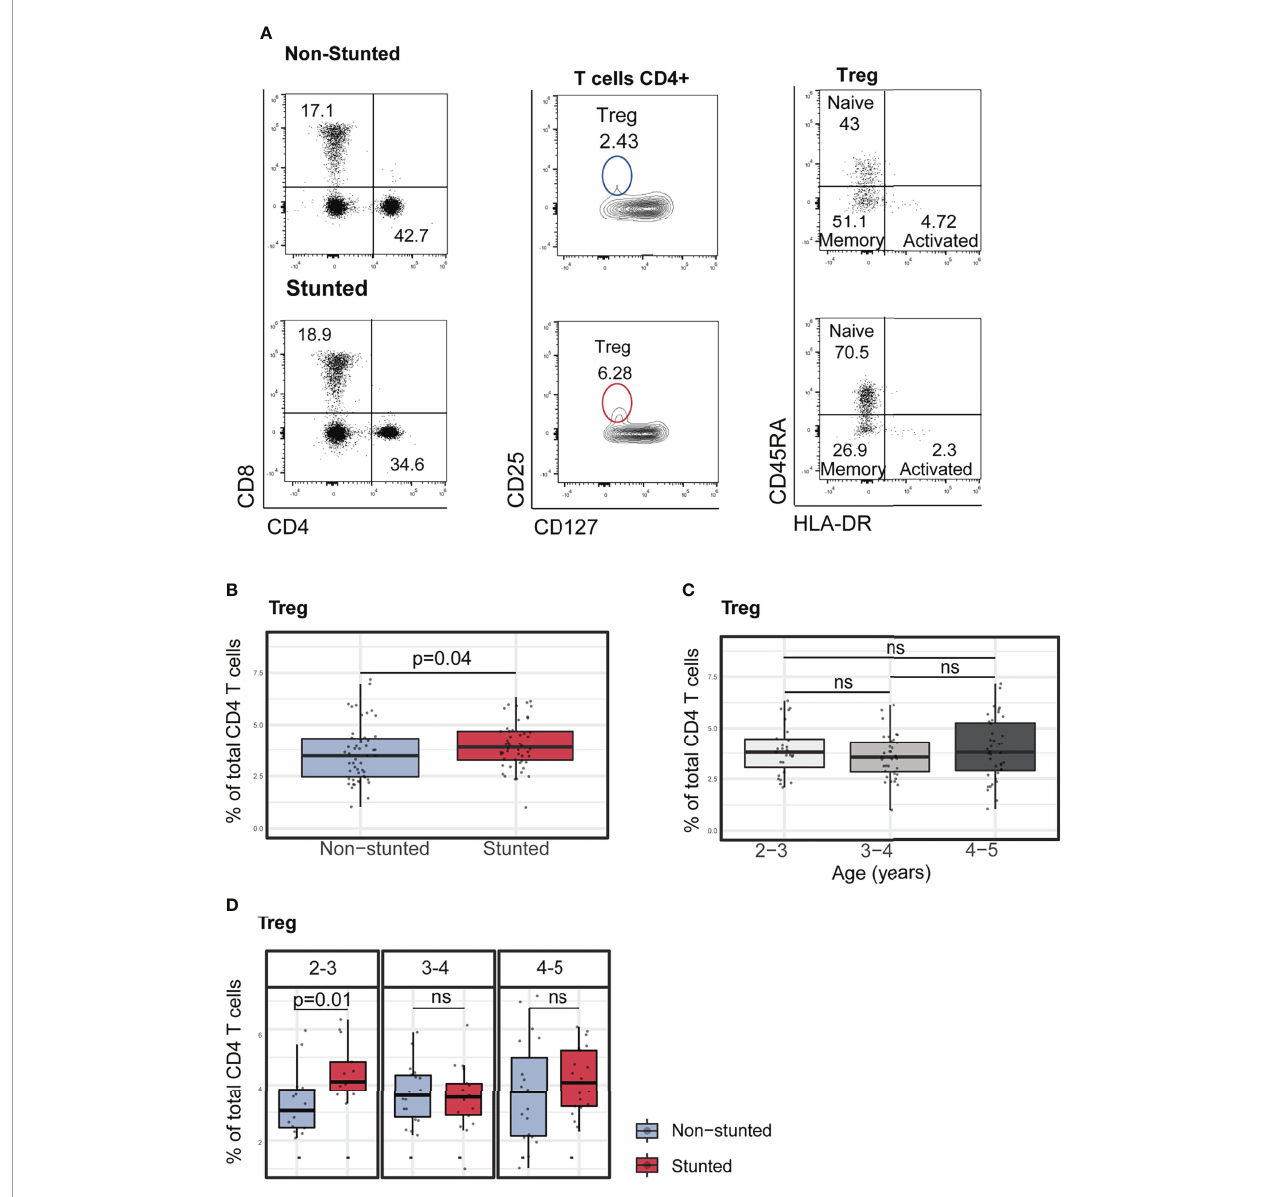
FIGURE 3 | Characterization of peripheral blood regulatory T cells (Treg) and their subsets in non-stunted vs. stunted children. (A) Representative fl ow cytometry dot plots showing the differences of Treg cell percentages from one non-stunted vs. one stunted child. Regulatory T cells were gated in CD4+ cells based on their expression of CD25 and CD127 markers. Naïve, memory and activated Treg cell subsets were determined based on their expression of CD127 and HLA-DR. (B) Relationship between Treg cell percentages and stunting status and (C) child age in years. (D) Representative graphs of regulatory T cell percentages by age sub-groups (years) and stunting status. Signi fi cance (p<0.05) was determined by Benjamini-Hochberg correction after Mann-Whitney test. N total= 103, N non- stunted = 51, N stunted= 52. ns, not signi fi